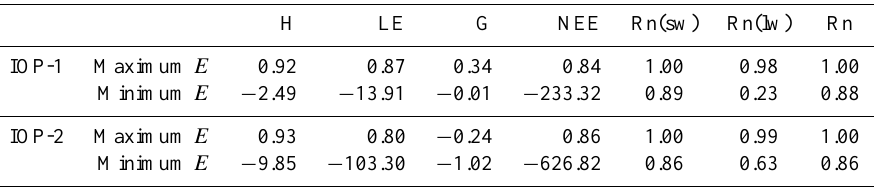
Table 3. Maximum and minimum values of the coefficient of efficiency E for sensible heat flux (H), latent heat flux (LE), ground heat flux (G), net ecosystem exchange (NEE), short-wave radiation budget (Rn(sw)), long-wave radiation budget (Rn(lw)) and for net radia- tion (Rn) for IOP-1 and IOP-2 (20000 runs each). H LE G NEE Rn(sw) Rn(lw) Rn IOP-1 Maximum E 0.92 0.87 0.34 0.84 1.00 0.98 1.00 Minimum E − 2.49 − 13.91 − 0.01 − 233.32 IOP-2 Maximum E